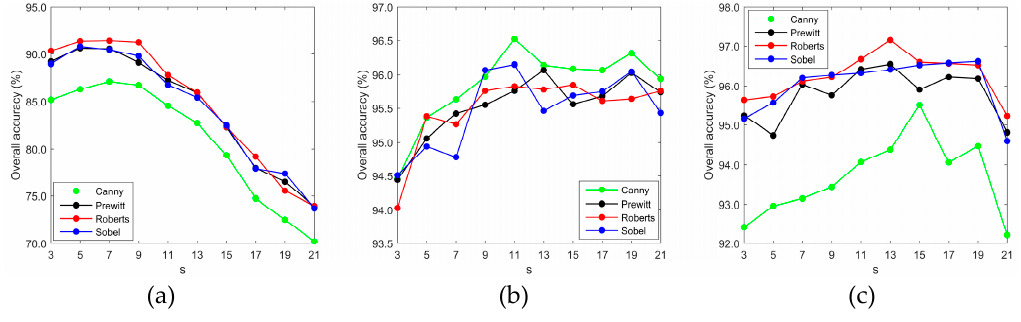
Figure 11. The variation of the average classification accuracy with increase of segmentation scale s . ( a ) Indian Pines. ( b ) Pavia University. ( c ) Salinas.